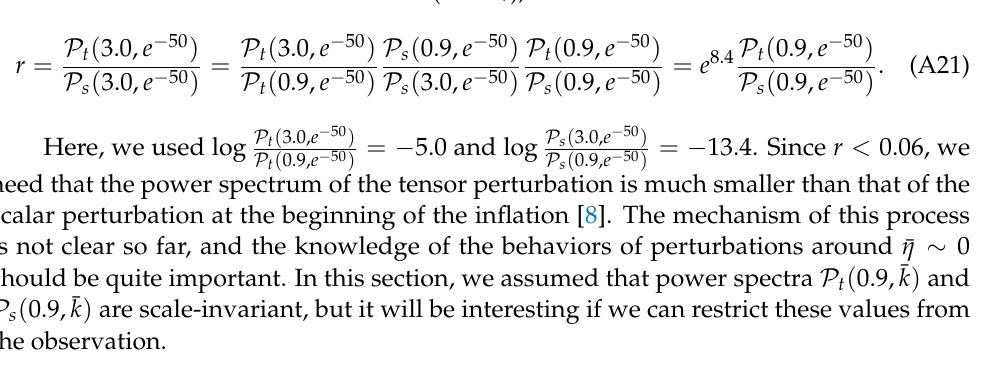
3.0,¯ k ) as a function of log k P s ( 0.9,¯ k )